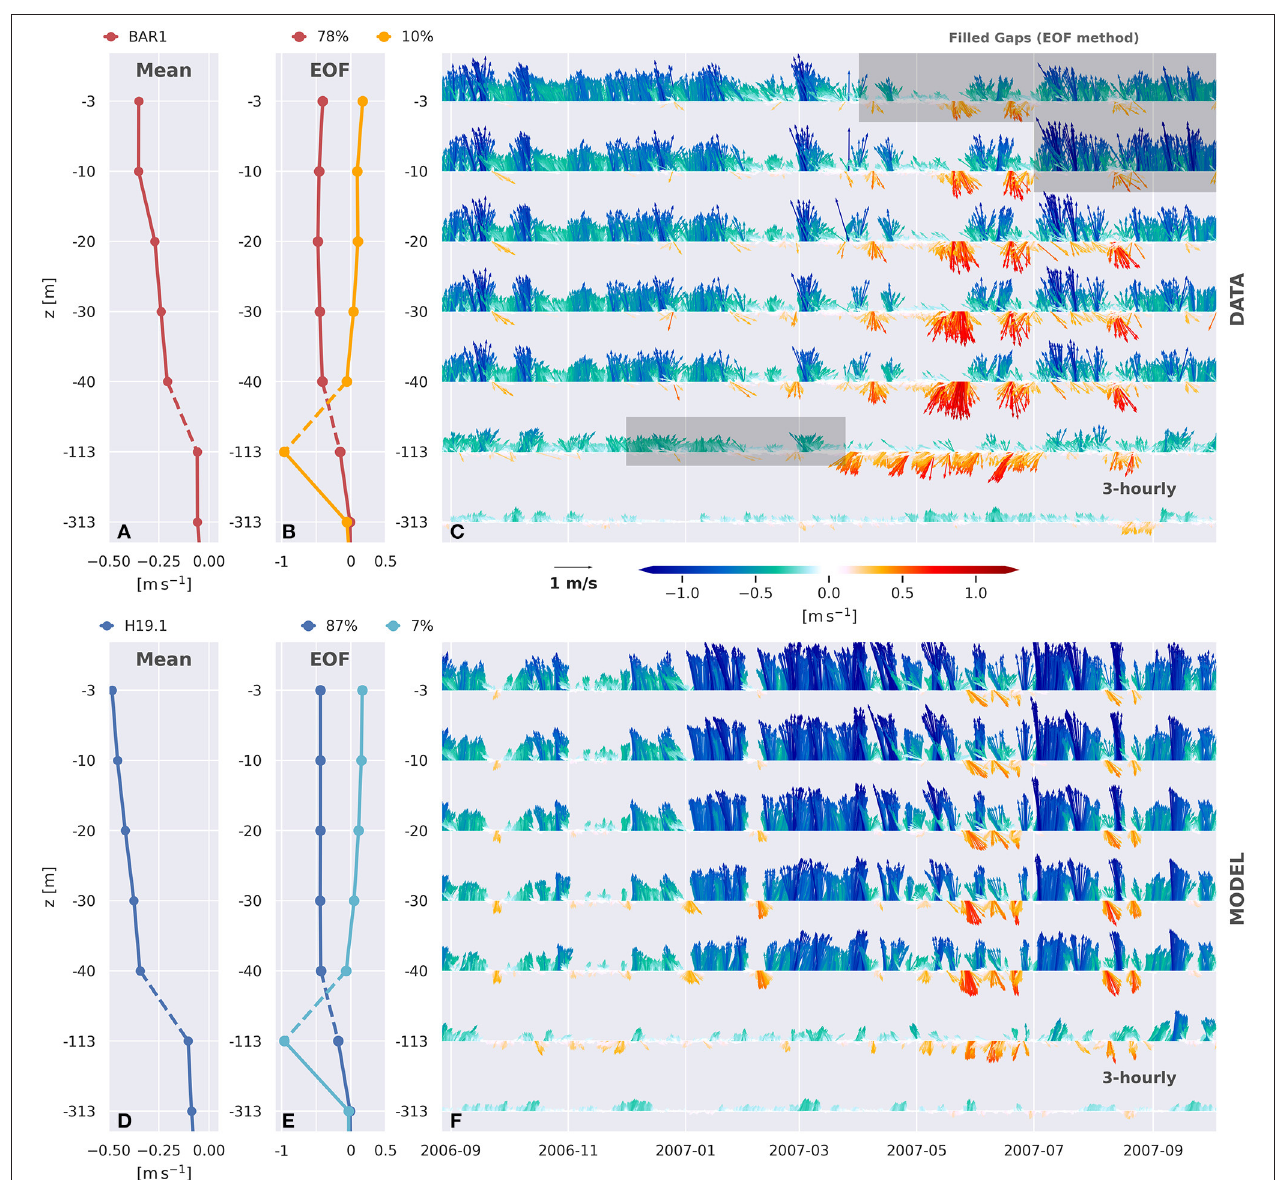
FIGURE 3 | (A) BAR1 along-slope velocity mean profile. (B) BAR1 EOF analysis for the along-slope velocity. (C) BAR1 velocity stick plot rotated by 90 ◦ . (D) HR19.1 along-slope velocity mean profile. (E) HR19.1 EOF analysis for the along-slope velocity. (F) HR19.1 velocity stick plot rotated by 90 ◦ ; y-axis represents along-slope velocity component. The percentages in the legend represent the total variance contained for each EOF. HR19.1 velocities are interpolated at the current meter depths. The vertical grid is stretched below